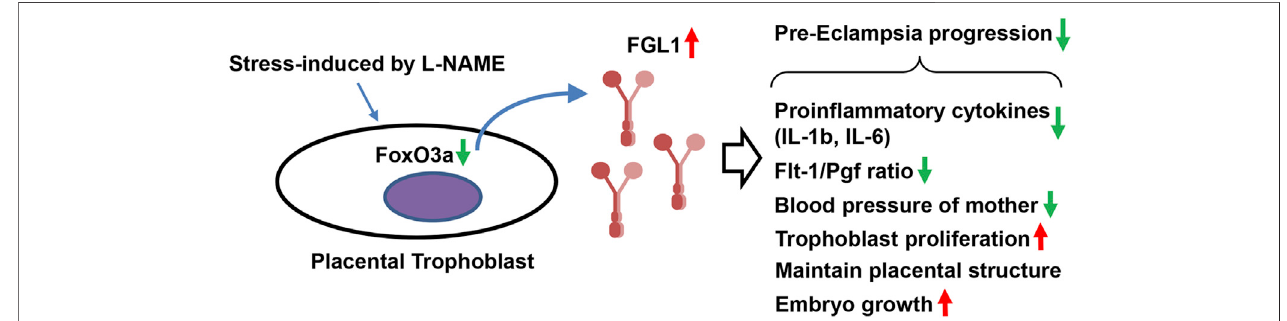
FIGURE 6 | Schematic representation. Stress-upregulated FGL1 expression, through FoxO3a reduction, may function as a compensatory factor that contributes to reducing the progression of PE by mediating trophoblast proliferation, proin fl ammatory cytokines, and angiogenesis-related biomarkers.